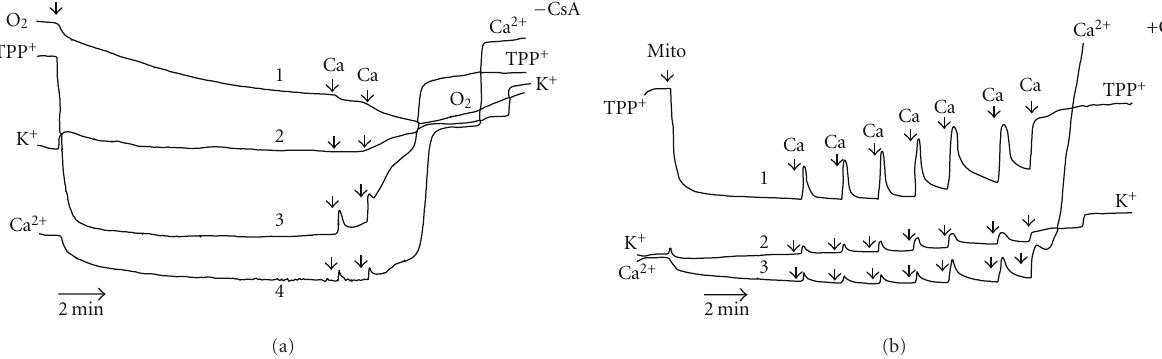
Figure 7: Simultaneous recordings of four mitochondrial parameters (respiration, ΔΨ mito, K + , and Ca 2+ fluxes) with the help of O 2 , TPP + , K + , and Ca 2+ -selective electrodes after treatment of isolated RLM with Ca 2+ in the absence (a) or presence of CsA (b). The additions of Ca 2+ (50 µ M) are indicated by arrows. The remainder is as in Figure